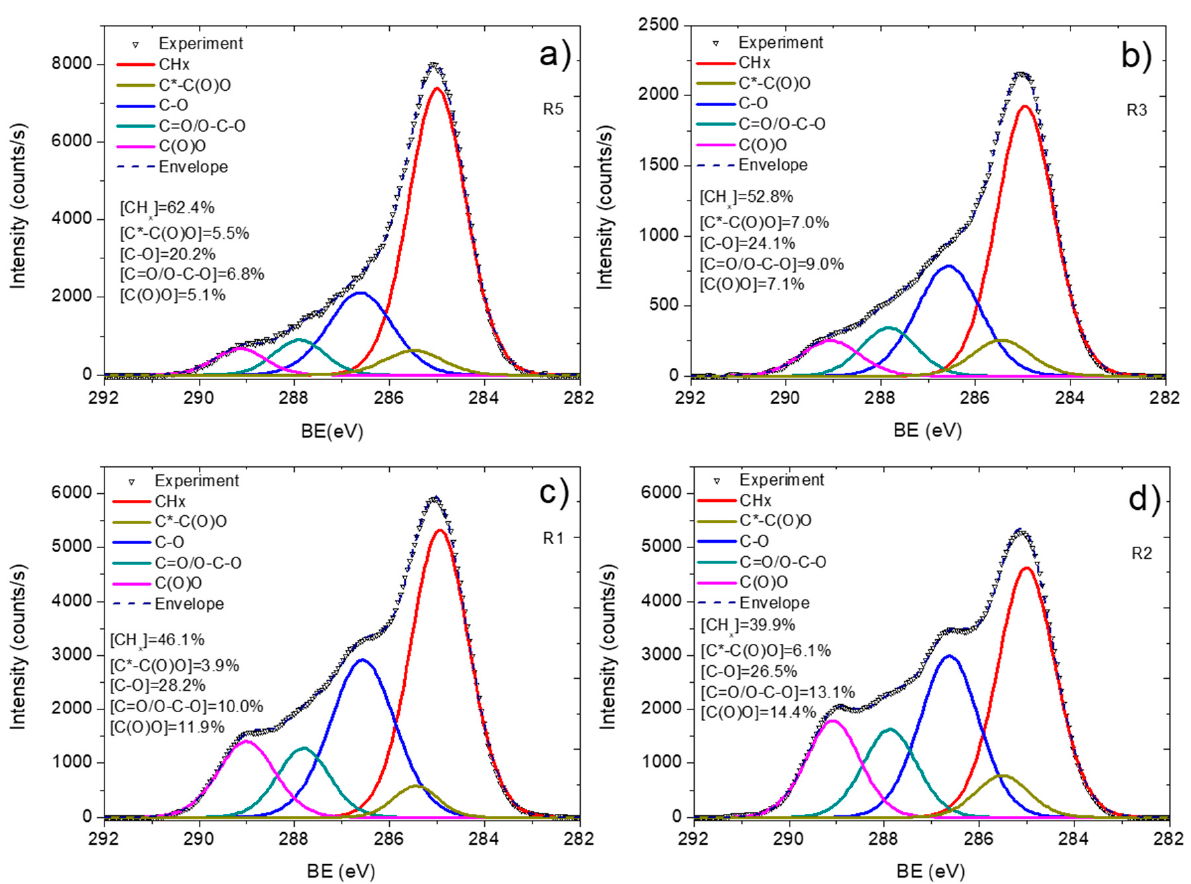
Figure 7. C1s XPS curve fitting of Ar/CO 2 /C 2 H 4 plasma polymerized layers deposited onto Si wafer at different CO 2 :C 2 H 4 ratios: 20:25 ( a ), 25:20 ( b ), 35:15 ( c ), and 35:10 ( d ).